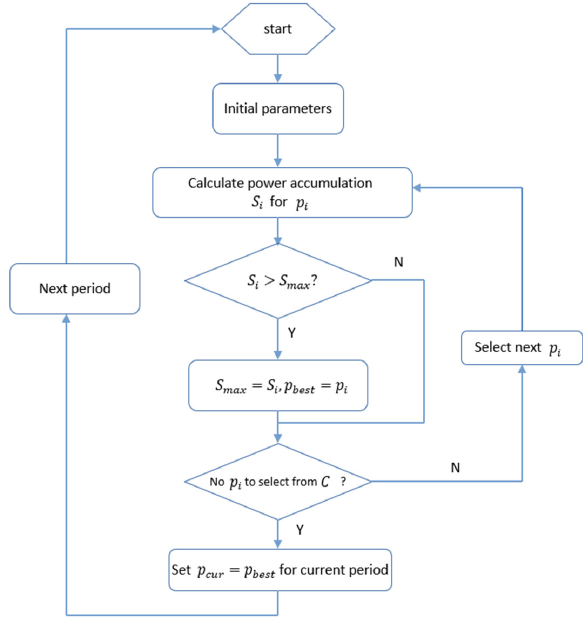
Figure 5. Flowchart of power optimization process.